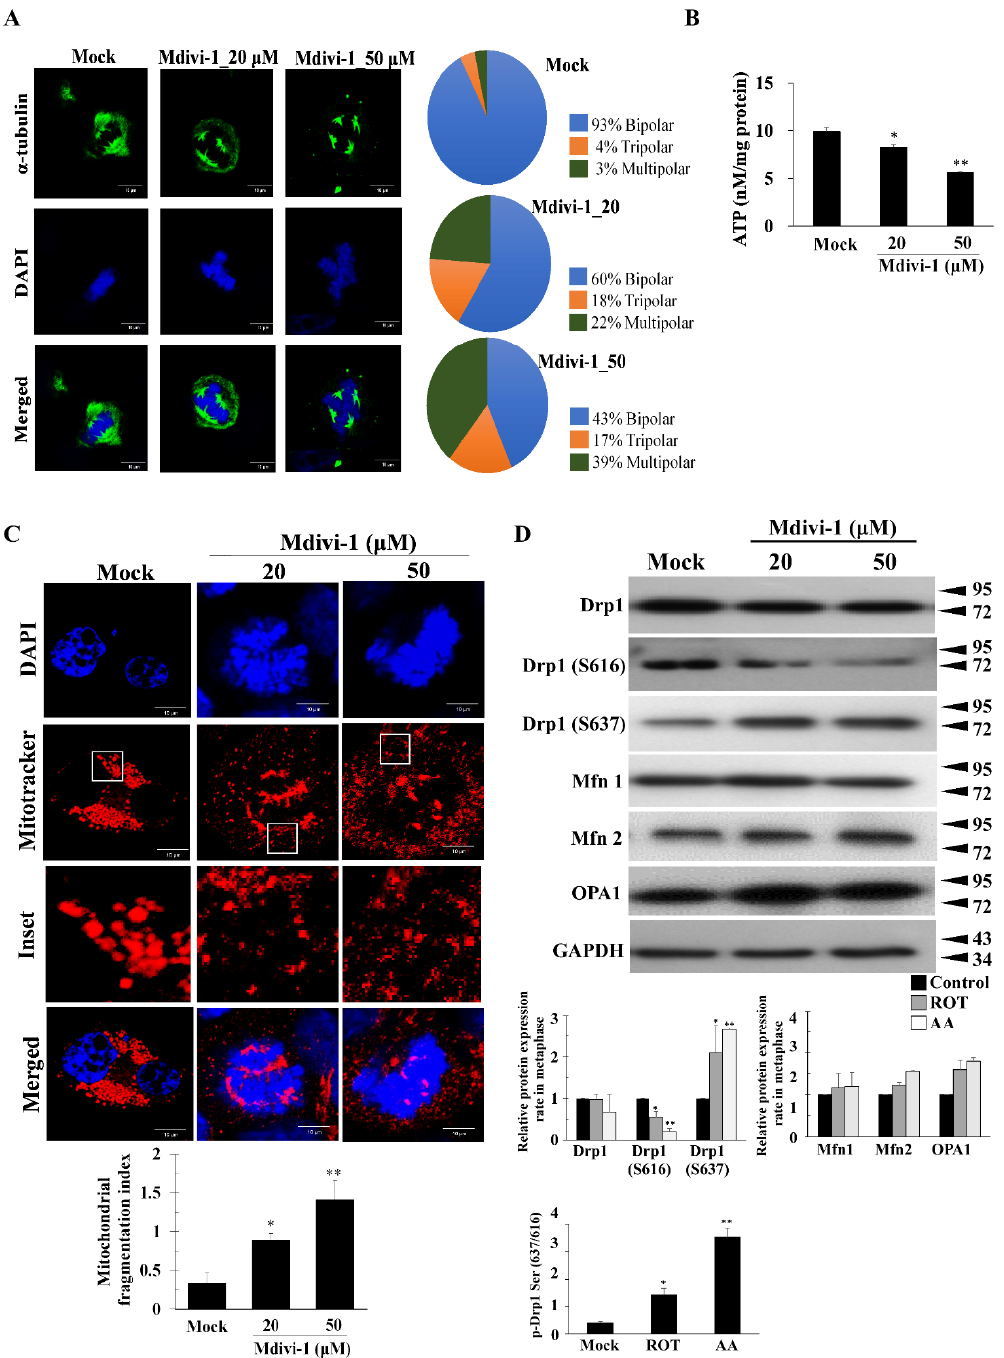
Figure 2. Mdivi-1 causes the formation of multiple spindles poles and uneven segregation. ( A ) HeLa cells were synchronized at G2/M by nocodazole, followed by the incubation for 24 h in drug-free medium in the absence (Mock) or presence of Mdivi-1. More than 300 cells were calculated. Quantitation pie charts indicate the percentage of bipolar, tripolar, and multipolar mitotic cells. ( B ) Normalized ATP measurements in HeLa cells. ( C ) HeLa cells were synchronized by either a double nocodazole block, release into fresh medium at the indicated time points, and then analysis by immunoblotting with antibodies against the indicated proteins. ( D ) Mitochondrial morphological features in the presence of Mdivi-1 were evaluated by the changes in mitochondrial dynamics. GAPDH was used as an internal control. The bar graph represents the mean of triplicates ± SD. * p < 0.05, ** p < 0.01 compared with the Mock